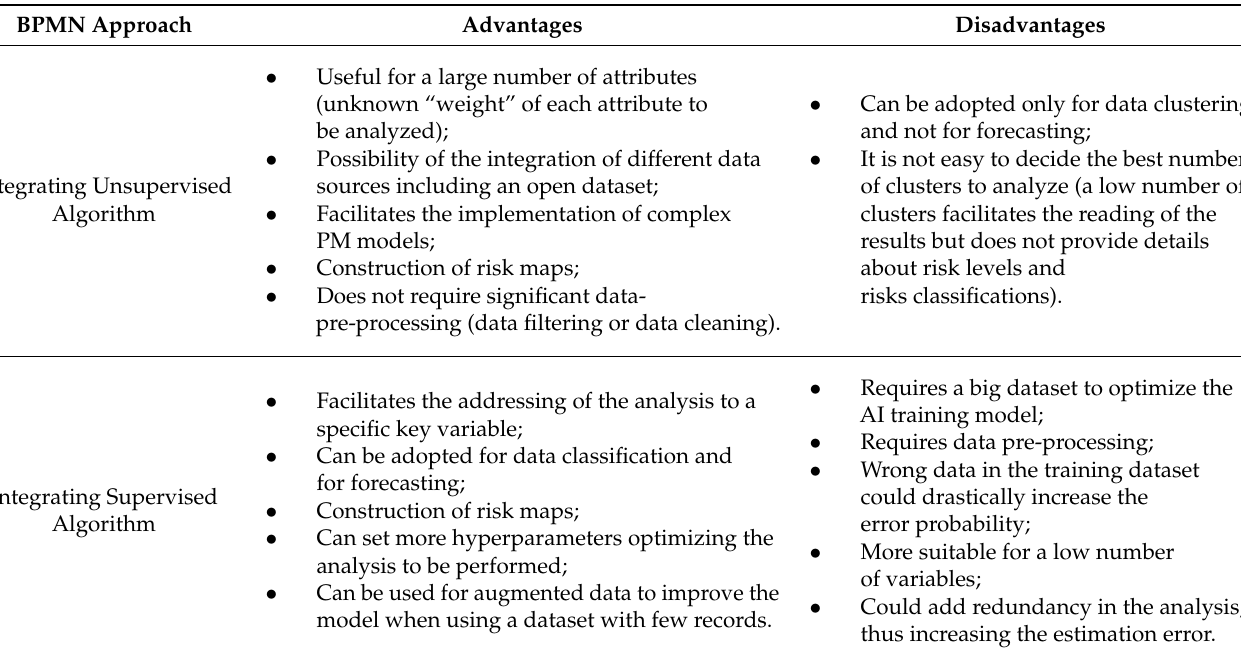
Table 3. Advantages and disadvantages of the BPMN-PM unsupervised and supervised algorithms. BPMN